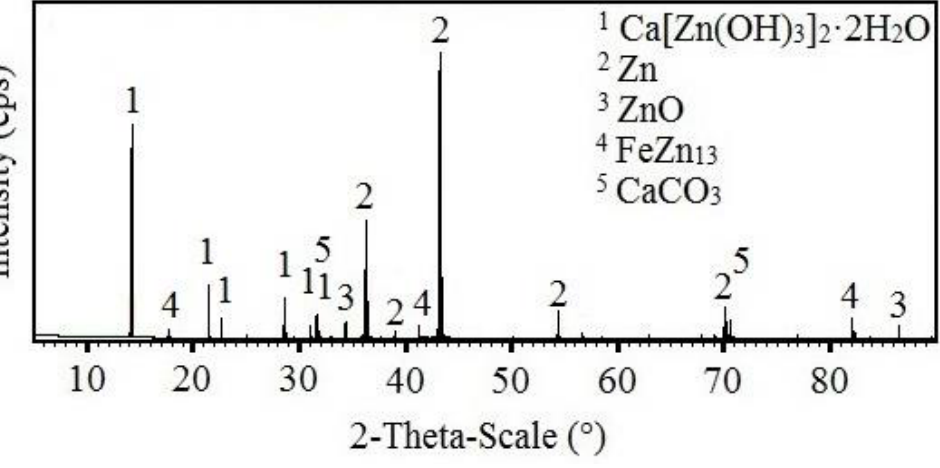
Figure 27. XRD analysis of HDG sample exposed for the duration of 3 months in simulated concrete pore solution of pH 12.8 with addition of MnO 4 − (Mn( 1 )).